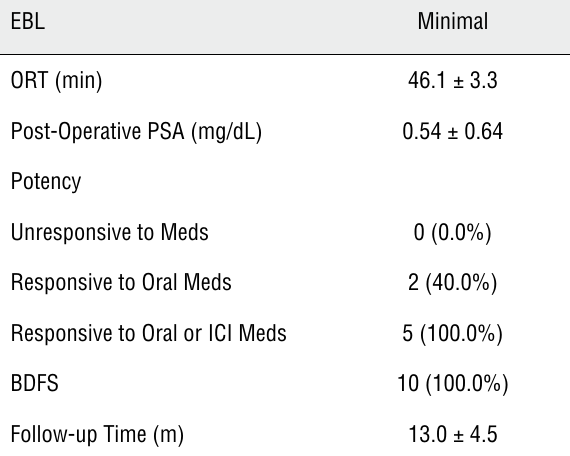
Table 2 - Surgical and Post-Operative